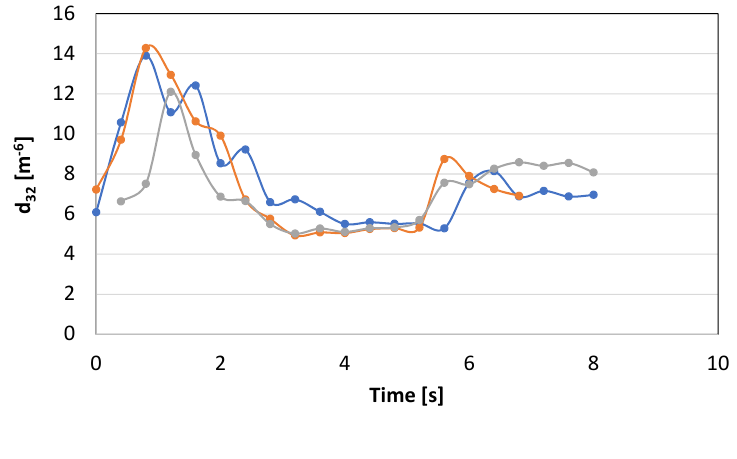
Figure 9. Three arbitrary time lines of the Sauter